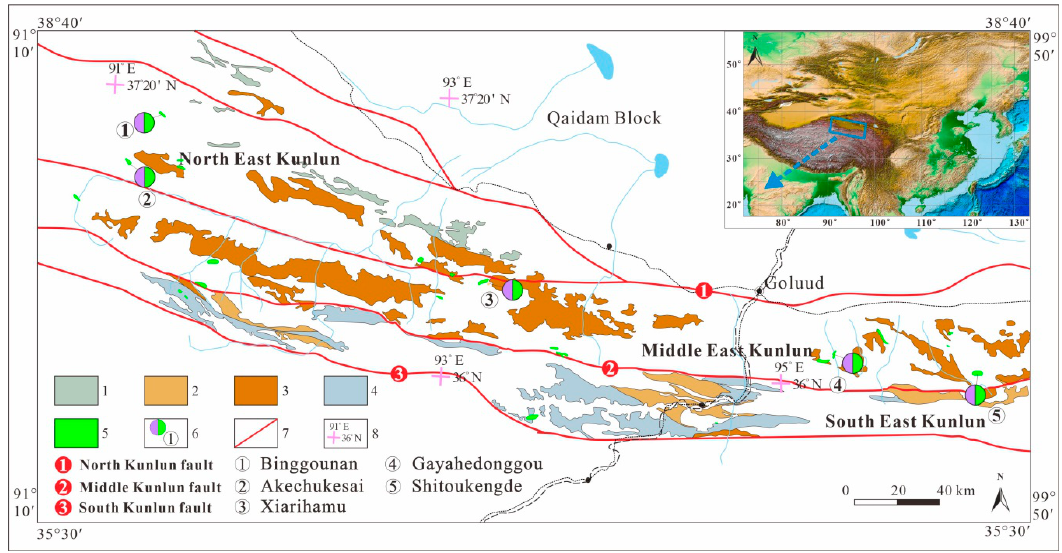
Figure 1. Geological map of the East Kunlun orogenic belt (EKOB). 1. Qimantage Group; 2. Wanbaogou Group; 3. Jinshuikou Group; 4. Nachitai Group; 5. Mafic–ultramafic intrusion; 6. Cu-Ni sulfide ore deposit; 7. Fault; 8. Longitude and latitude.